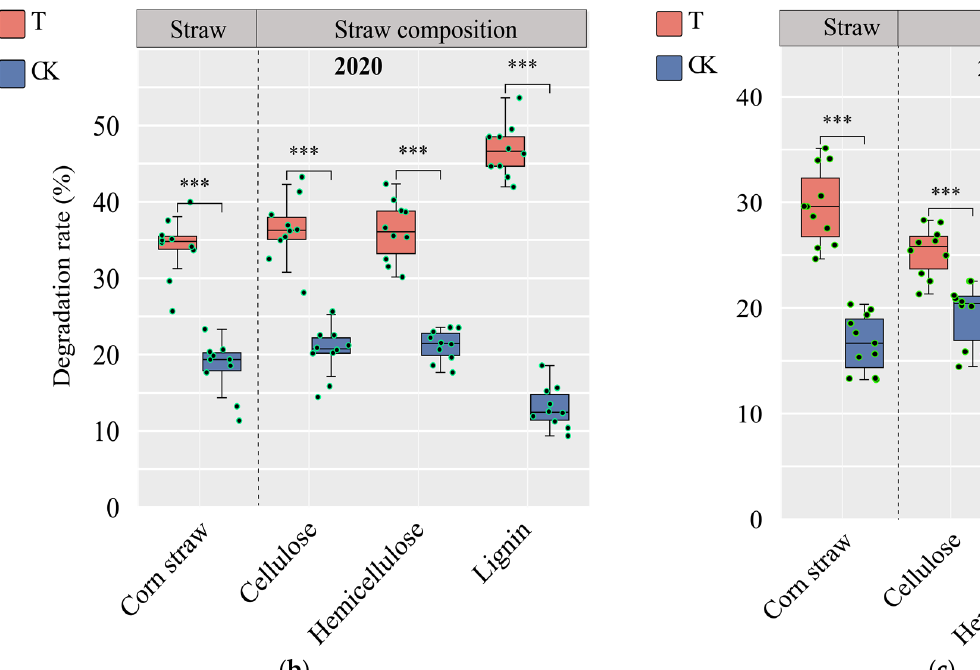
Figure 4. Effectiveness of the tested bacterial agents in the laboratory and in field conditions. Degradation rates of corn stover and its components in the ( a ) laboratory and in field tests conducted in ( b ) 2020 and ( c ) 2021. * p ˂ 0.05, ** p ˂ 0.01, *** p ˂ 0.001. T: bacterial agent application treatment. CK: control group.